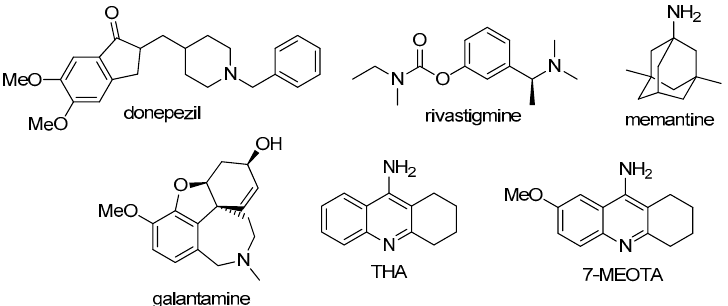
Figure 1. Structures of currently available drugs for the treatment of AD—donepezil, rivastigmine, memantine, and galantamine, and structures of THA and its methoxy derivative